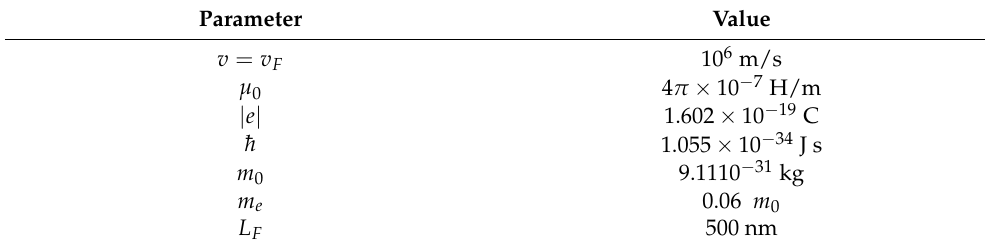
Figure 2. Surface admittance in the low field limit considering the linear dispersion (graphene). Table 1. Parameter and constant values adopted in the